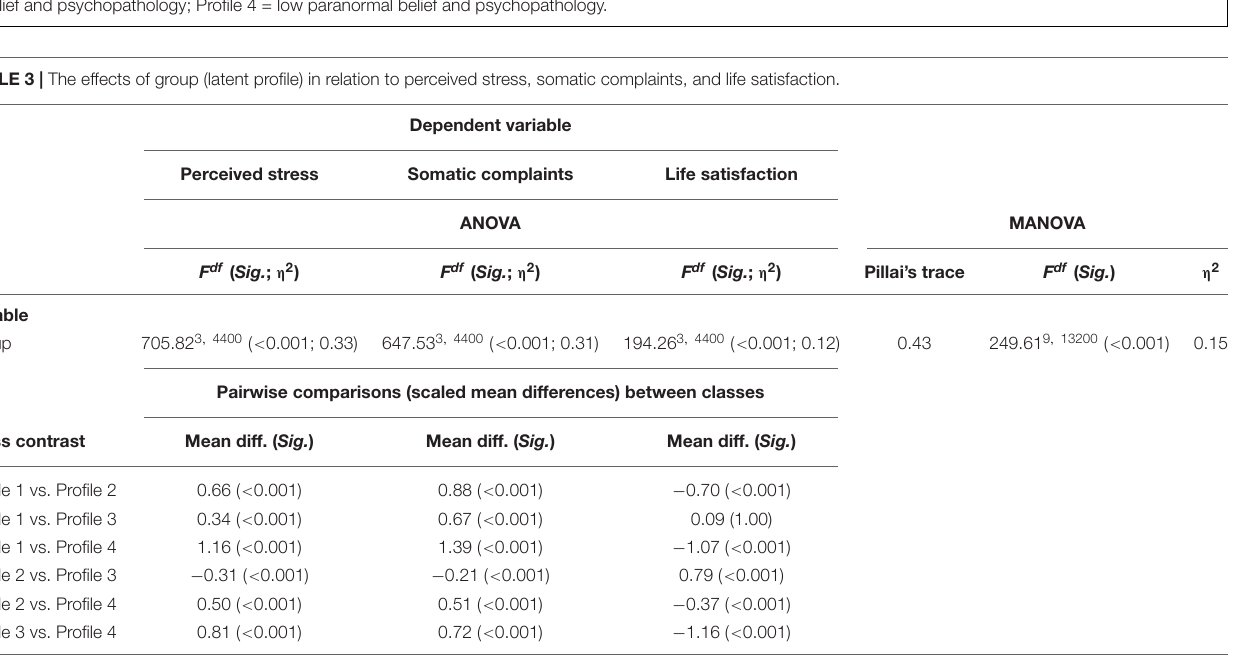
FIGURE 1 | Pattern of scaled mean scores for paranormal belief, schizotypy, depression, and manic depressiveness as a function of latent profile. Profile 1 = high paranormal belief and psychopathology; Profile 2 = high paranormal belief and unusual experiences; moderate psychopathology; profile 3 = moderate paranormal belief and psychopathology; Profile 4 = low paranormal belief and psychopathology.